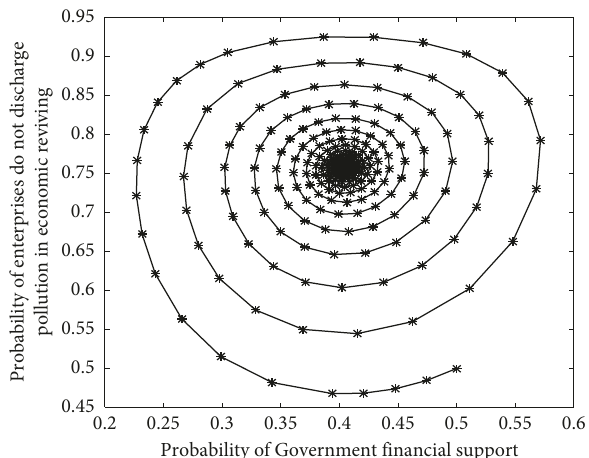
Figure 9: The evolution path when the initial probabilities of both sides of the game are the same under the dynamic incentives mechanism and penalties mechanism.